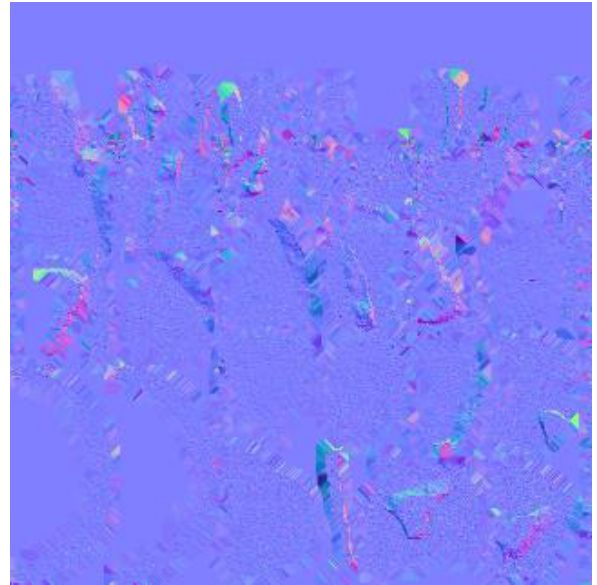
Figure 17. Normal map (left)